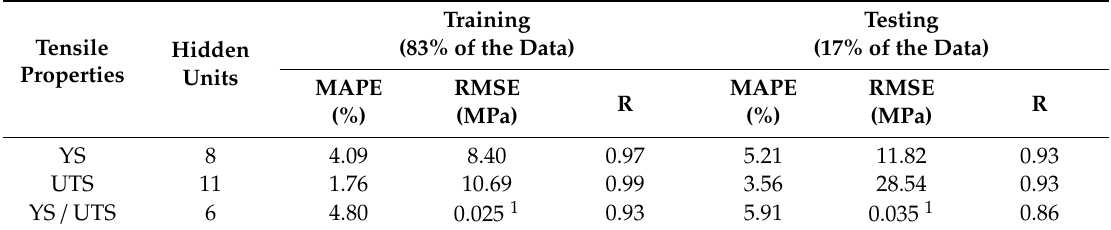
Table 2. Statistical parameters for the training and testing set with the optimal hidden units.